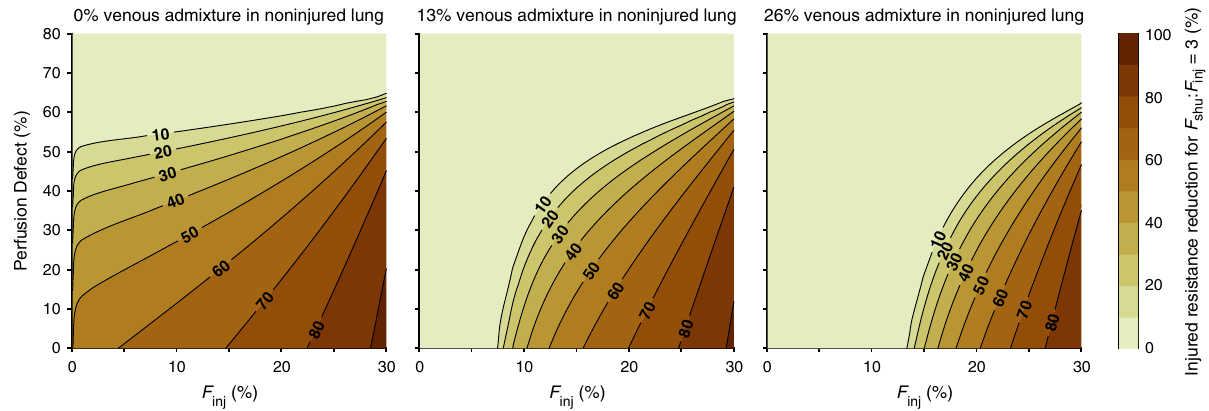
Fig. 6 Interplay between perfusion defect and altered hypoxic pulmonary vasoconstriction. Color indicates the amount of vasodilation required to produce a ratio of shunt fraction ( F shu ) to injured fraction ( F inj ) of 3, for a given fraction of injured lung ( F inj ) and fraction of noninjured lung with perfusion defect. Baseline perfusion gradient was 30%, and injury was focused in the lower lung